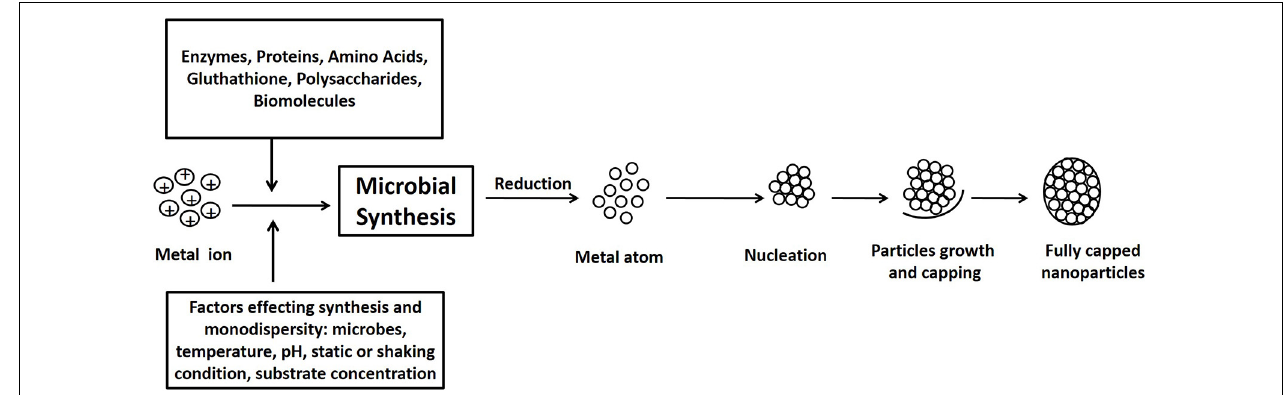
FIGURE 1 | Schematic diagram of mechanisms of nanoparticle synthesis by microbes: the pathway of nanoparticle synthesis by microbes involves metal capture, enzymatic reduction, and capping. Several biomolecules such as proteins, amino acids, and polysaccharides found in the microbial extracts help in the stabilization of the